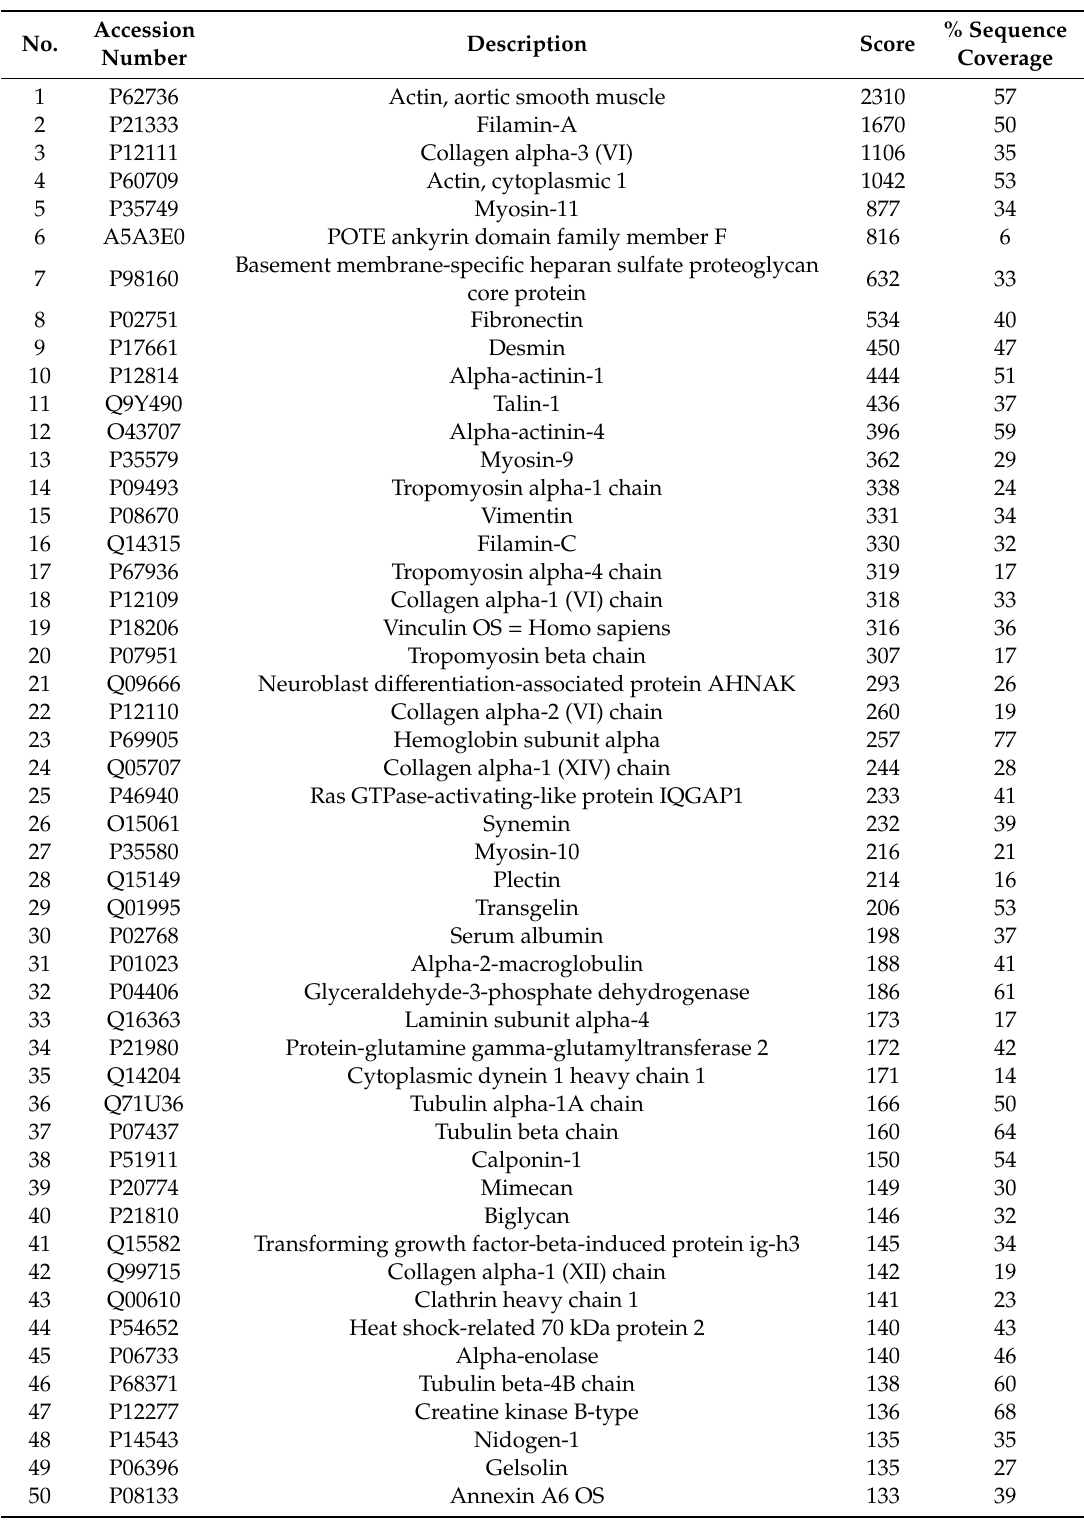
Table 1. List of representative identified proteins in native human umbilical arteries (hUAs).